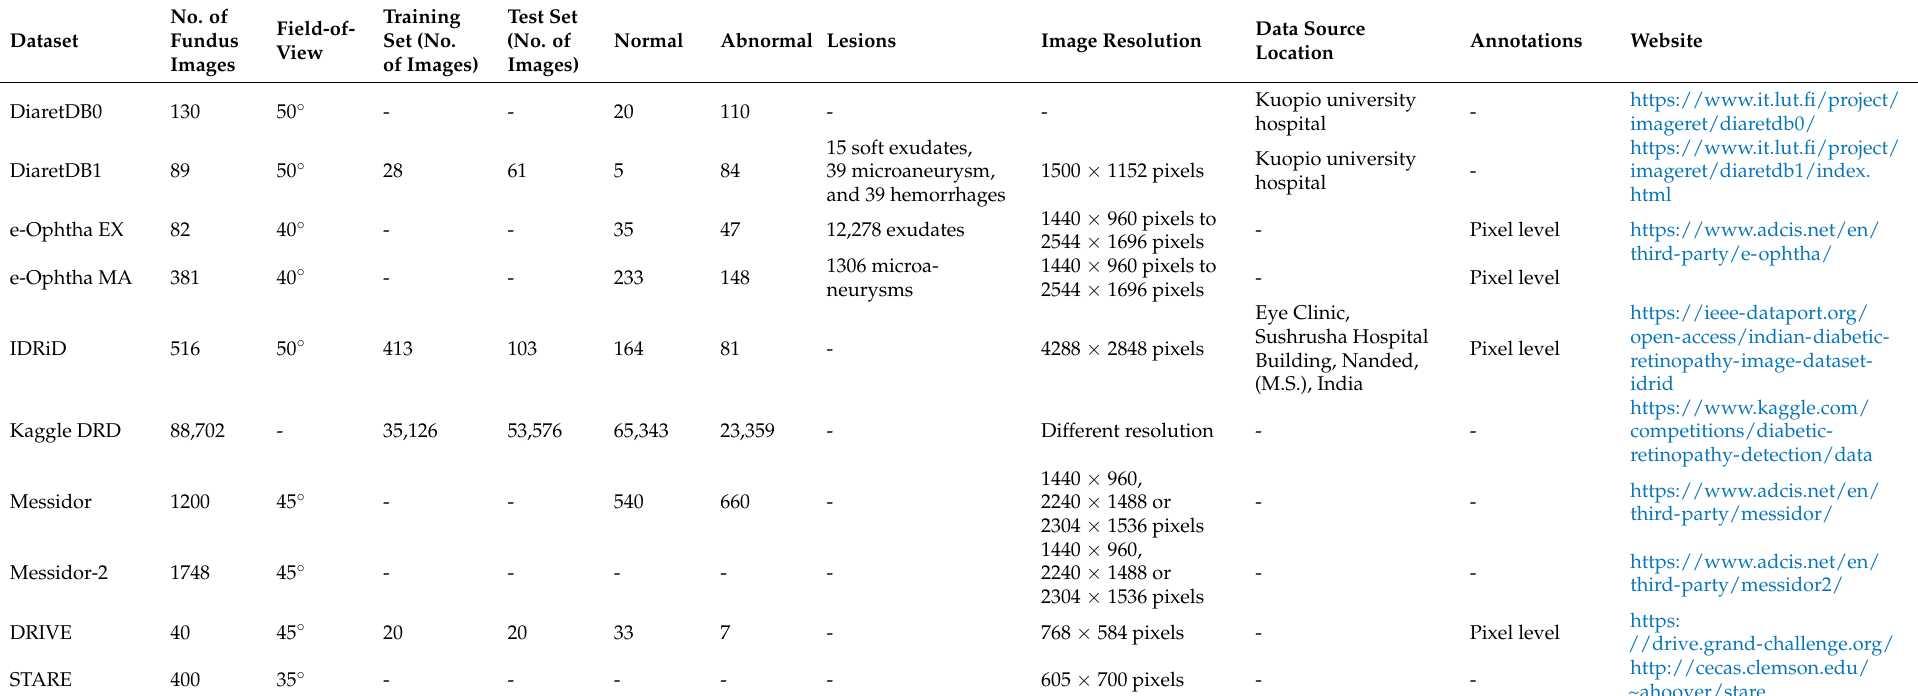
Table 4. Details of diabetic retinopathy